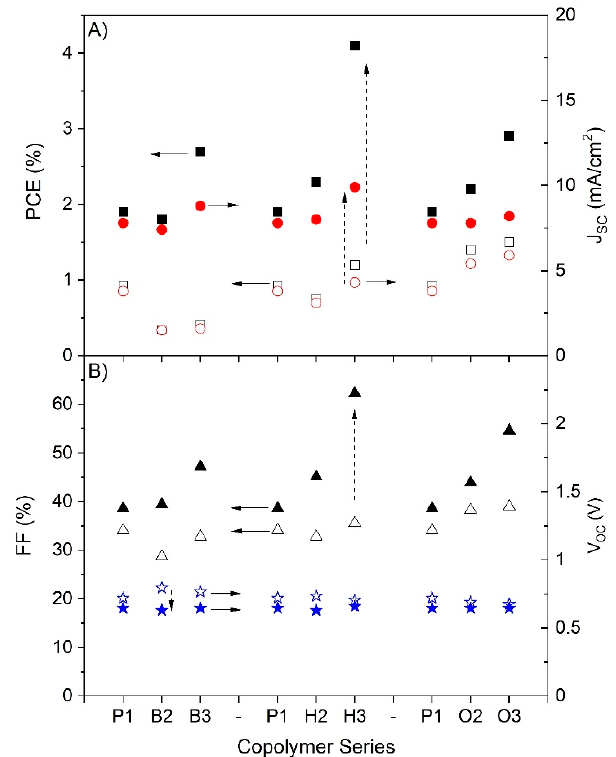
Figure 8. PV device parameters of used copolymer solar cells; ( A ) PCE (rectangles) and J SC (circles), ( B ) FF (triangles) and V OC (stars); open symbols for before annealing and solid symbols for after annealing.